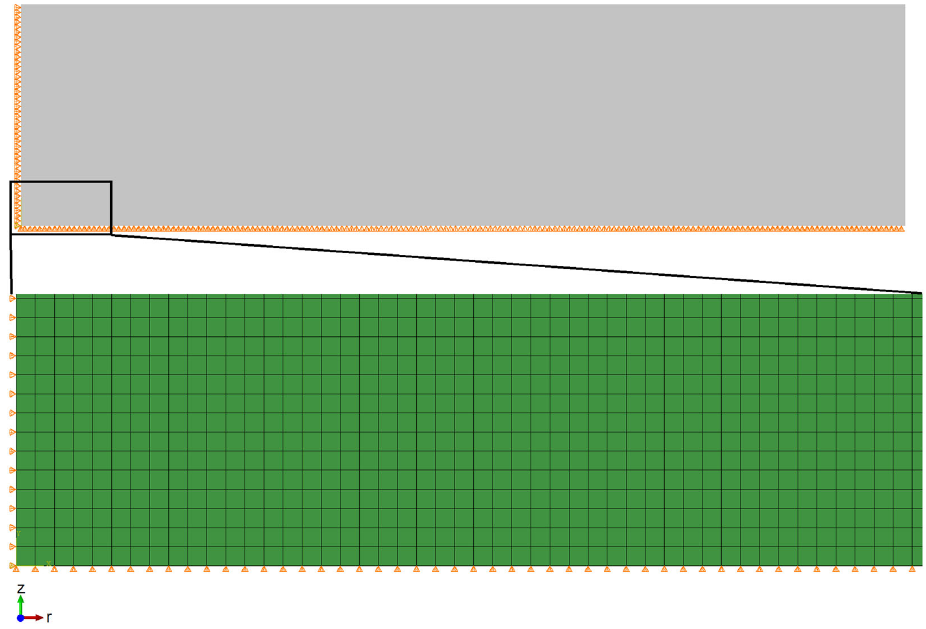
Figure 3. Geometry and mesh of the numerical